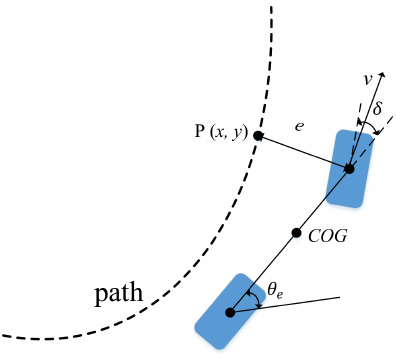
Figure 3. The Stanley